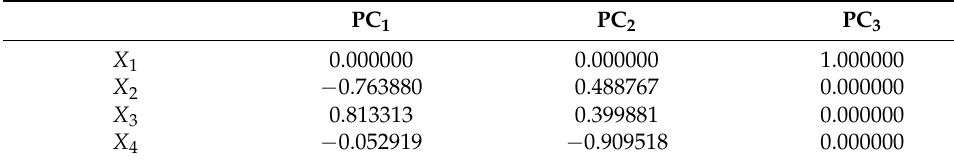
Table 4. Characteristic loading coefficients for the first three principal components.